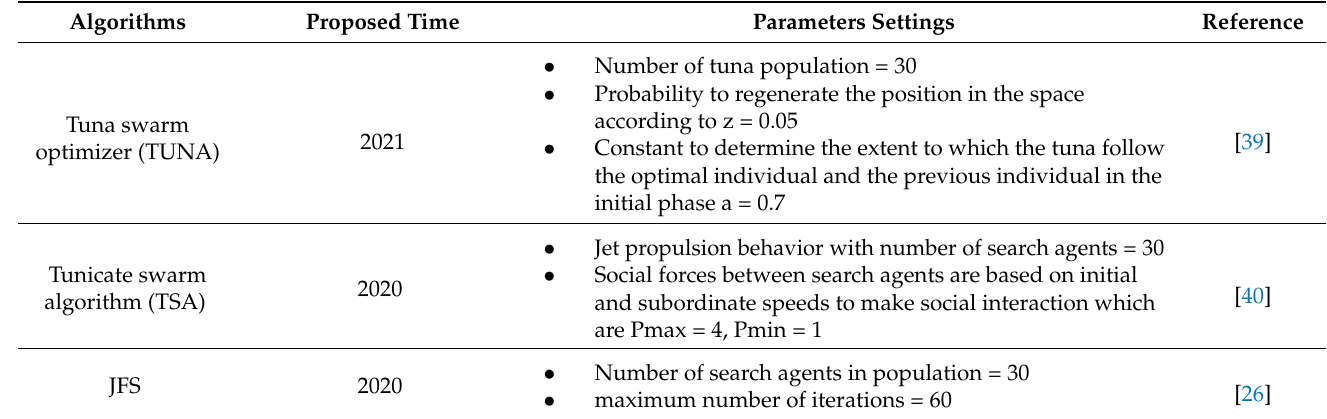
Table A1. Essential parameter settings in all techniques, i.e., TSA, TUNA, and JFS.